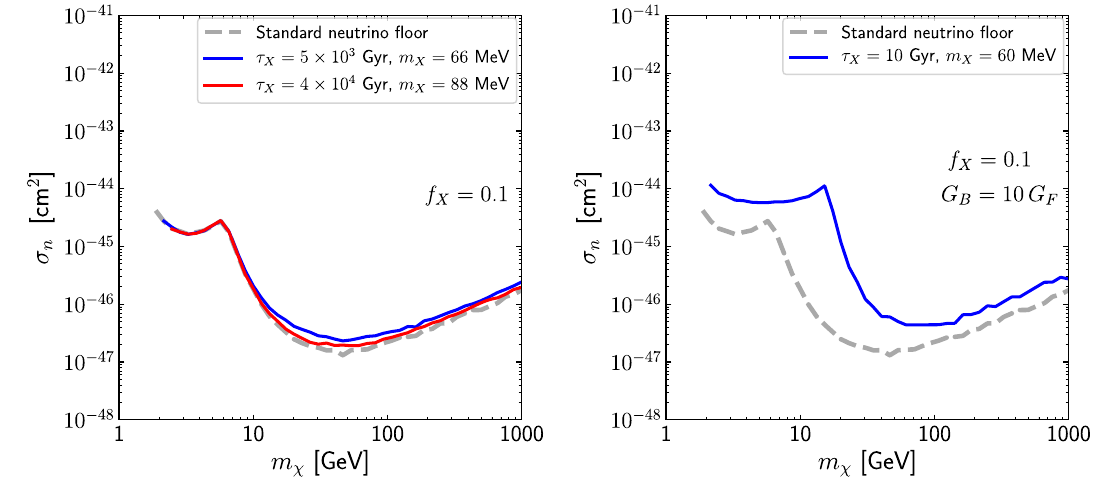
= 0 . 1 keV, exposure of 1 ton-year, thr